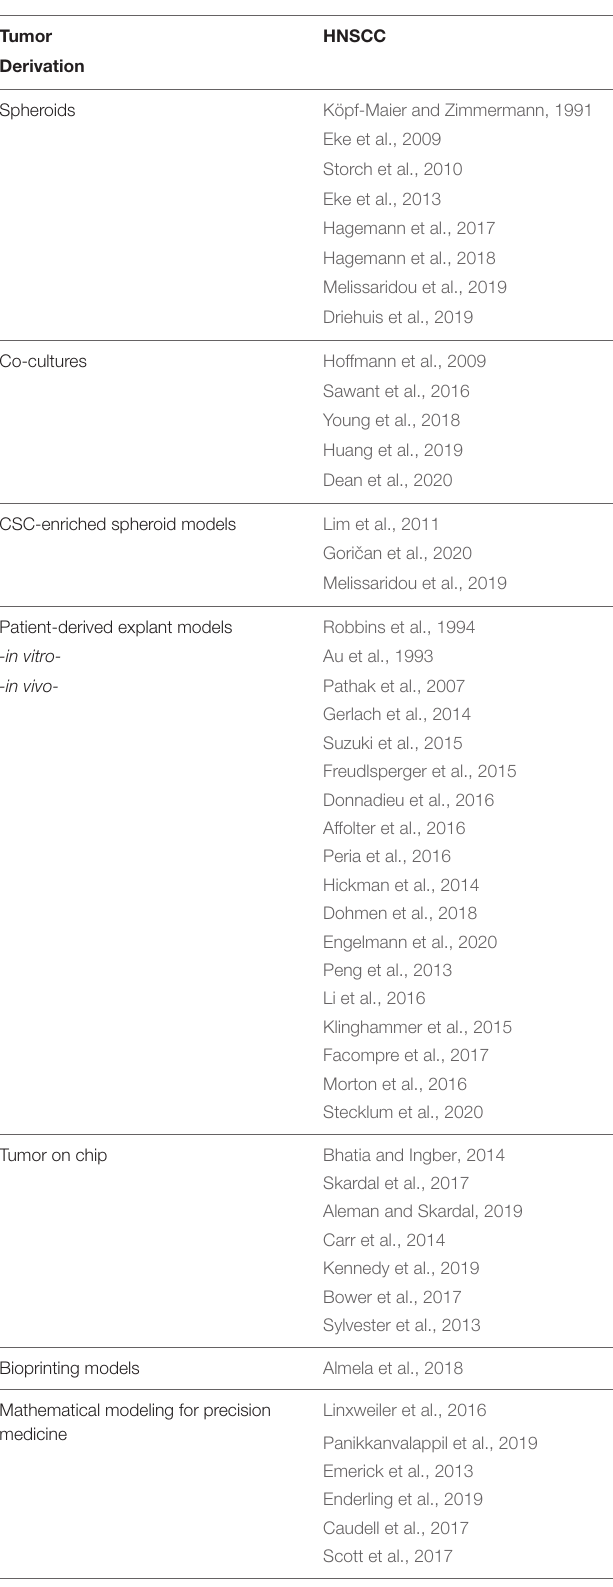
TABLE 1 | Preclinical 3D models for